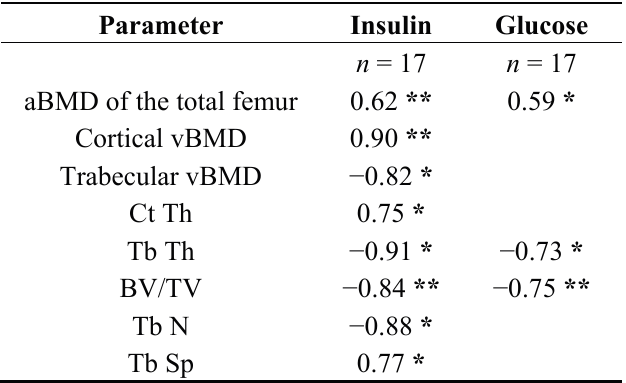
Table 1. Correlation analysis between serum insulin, glucose levels and bone mass and micro-structure parameters at 26